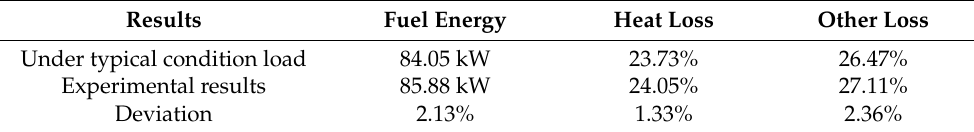
Table 7. Engine energy flow results comparison under transportation conditions.